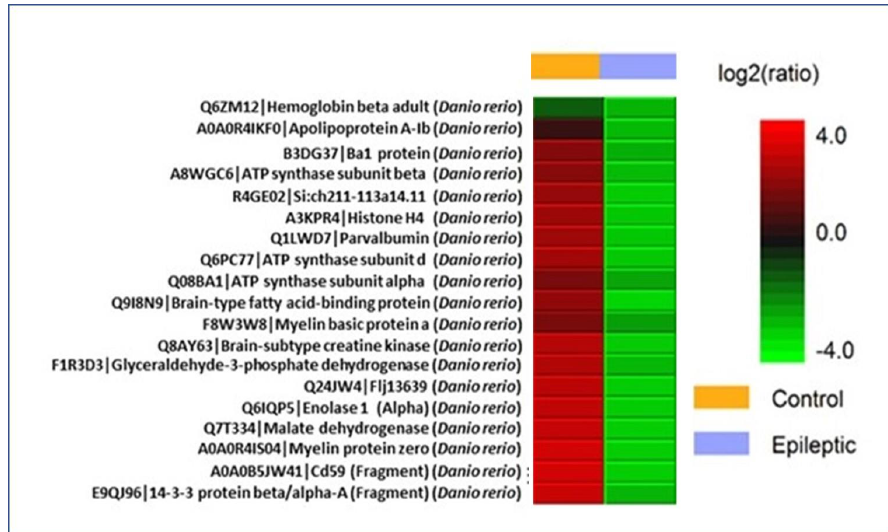
Figure 8. Differential expression (LFQ) of normal vs. epileptic zebrafish brain protein extract denoted by heat map. Label free quantification heat map for proteins identified from zebrafish brain (control vs. epileptic). Proteins with high ratio and low ratio are labelled red and green respectively. Samples are taken in triplicate where yellow line denotes epileptic group and light blue line denotes normal control group.